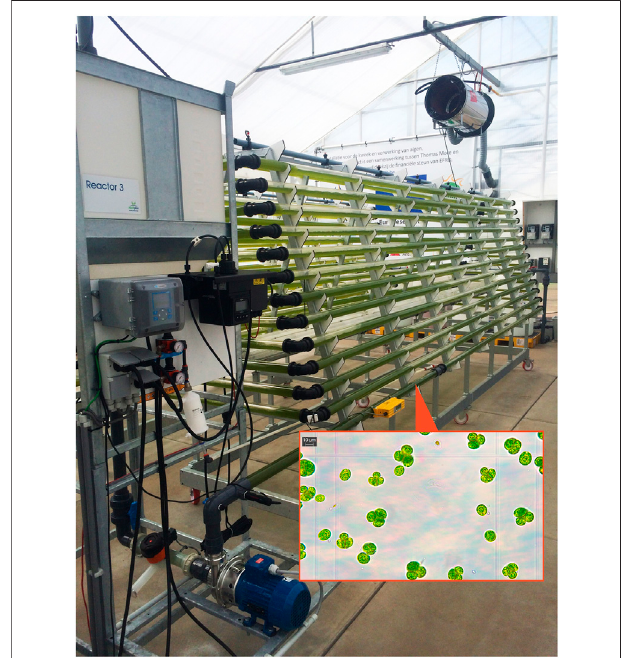
FIGURE 1 | Picture of the photobioreactor used to perform the growth experimentswith C.typhlos .Thered frameshowsthe C.typhlos cellsasseen throughout the experiments. The cells were always